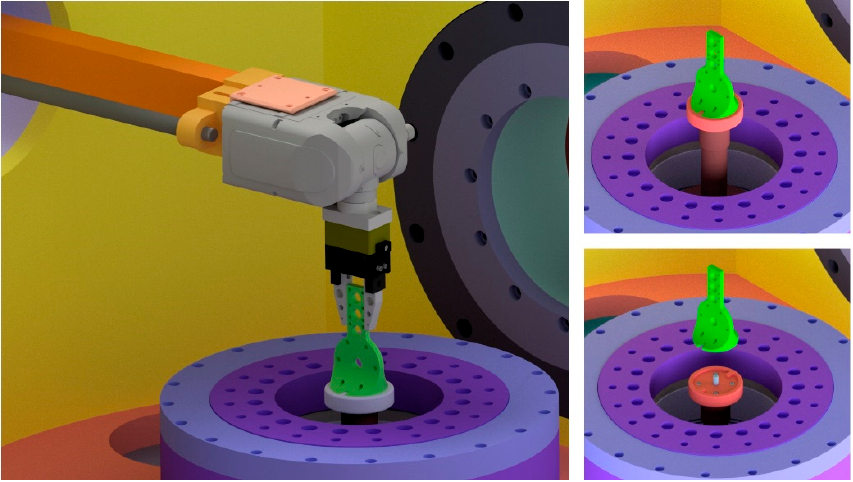
Figure 5. Left : 3D drawing of the robotic arm clamping a target. Right : details of the target hosted on the cold finger of the cryocooler.